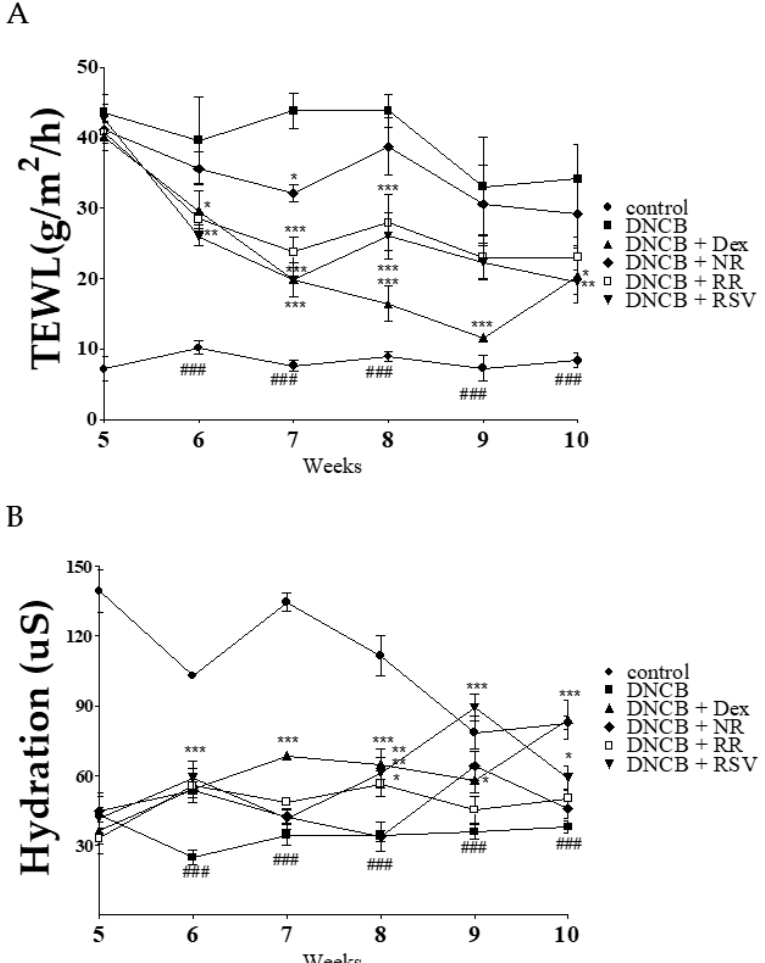
Figure 3. Effect of RR on TEWL and hydration in DNCB-induced NC/Nga mice. ( A ) The level of TEWL; and ( B ) the level of hydration in NC/Nga mice dorsal skin were measured using the Derma Combo system every week. Values are expressed as means ± SEM. ### p < 0.001 versus vehicle group; * p < 0.05, ** p < 0.01, and *** p < 0.001 versus DNCB-treated group. DNCB, 2,4-dinitrochlorobenzene; RR, resveratrol-enriched rice; SEM, standard error of the mean; TEWL, trans-epidermal water loss.